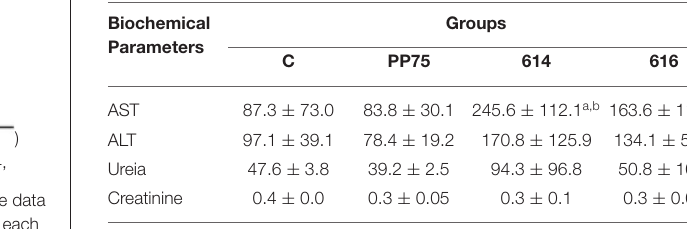
TABLE 3 | Biochemical profile from non-infected animals (C; control group) and experimentally L. infantum- infected groups (reference strain: PP75; and wild strains: 614 and 616).